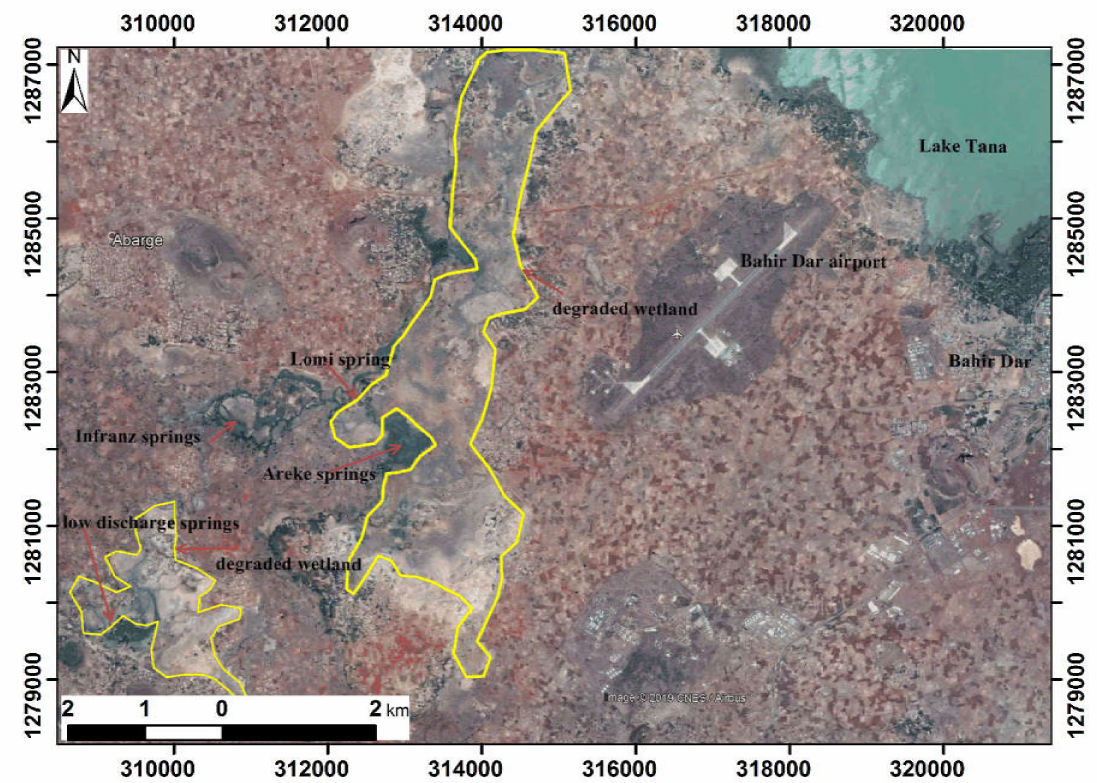
Figure 5. Map showing wetland areas in the dry season and dried wetlands (Google Earth Pro image of March 23, 2013, 37P: 316279.39 E, 1283918.30 N, eye alt, 19.23 km, Image © 2019 CNES / Airbus, https: // www.google.com / maps / @11.60951,37.31492,28383m / data = !3m1!1e3), yellow lines representing boundaries of